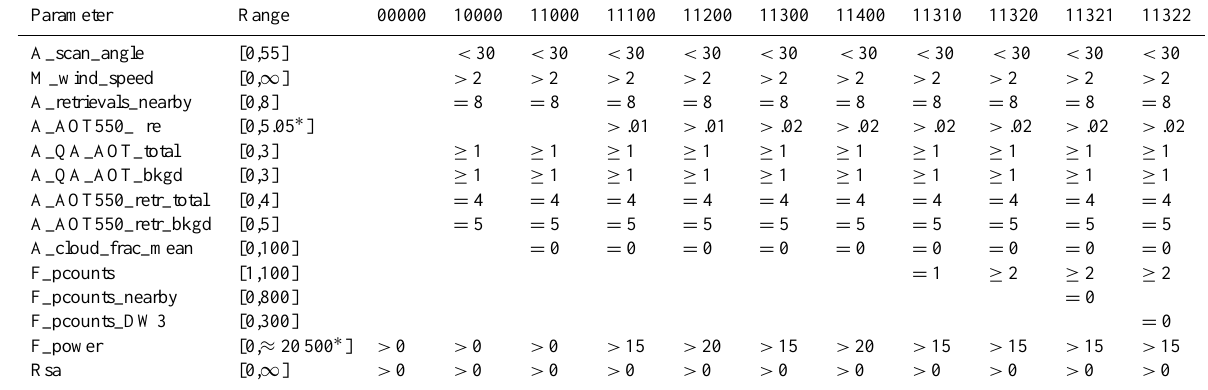
Table 2. Value ranges of the threshold parameters in Table 1 and the combinations of their threshold settings used to derive the different five-digit filter configurations (00000, 10000, 11000, etc.) that were applied in screening out potentially erroneous or corrupted data during the grid-level data analysis described in Sect.